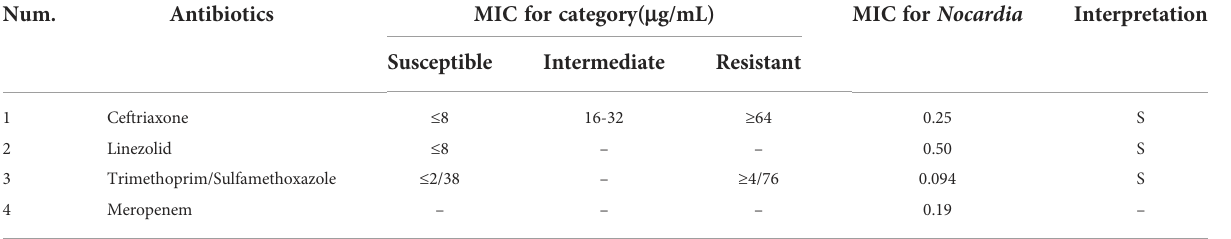
TABLE 2 The antibiotic susceptibility of Nocardia from the bronchoalveolar lavage fl uid. Num.